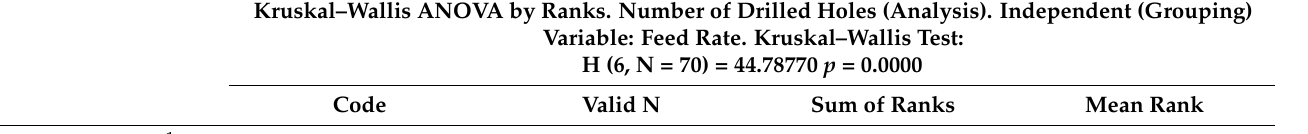
Table 6. Results of the comparison of the number of holes drilled up to the moment of tool damage in terms of feed rate.